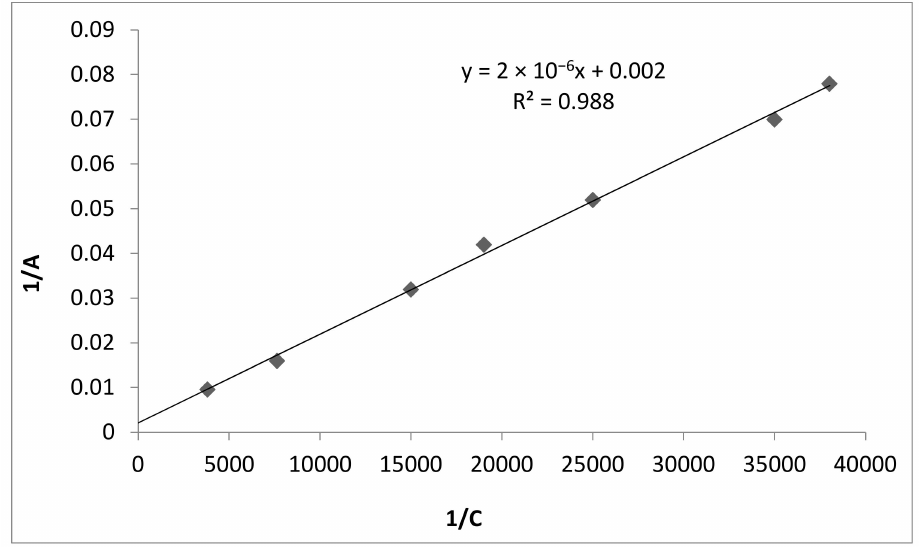
Figure 3. Isotherm for fluoride ions adsorption from solution, represented according to linearized coordinates (ratio of adsorbate-adsorbent solution 1000:1 (mL/g)). Solving the equation graphically (8) in coordinates ln